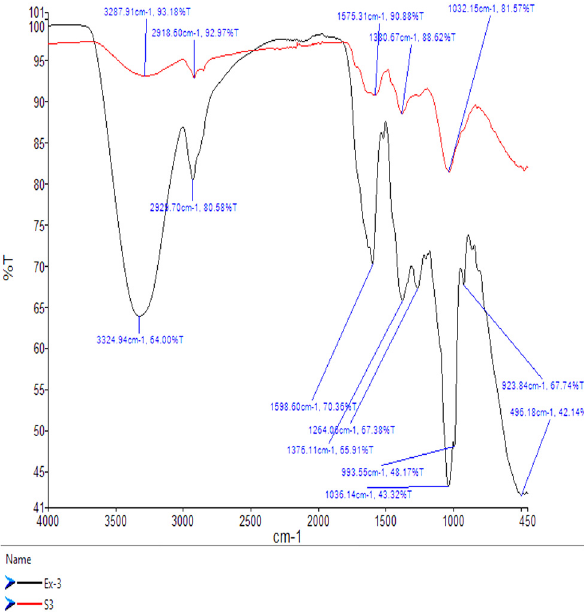
Figure 6: Comparative FTIR spectra of pure extract and AgNPs.